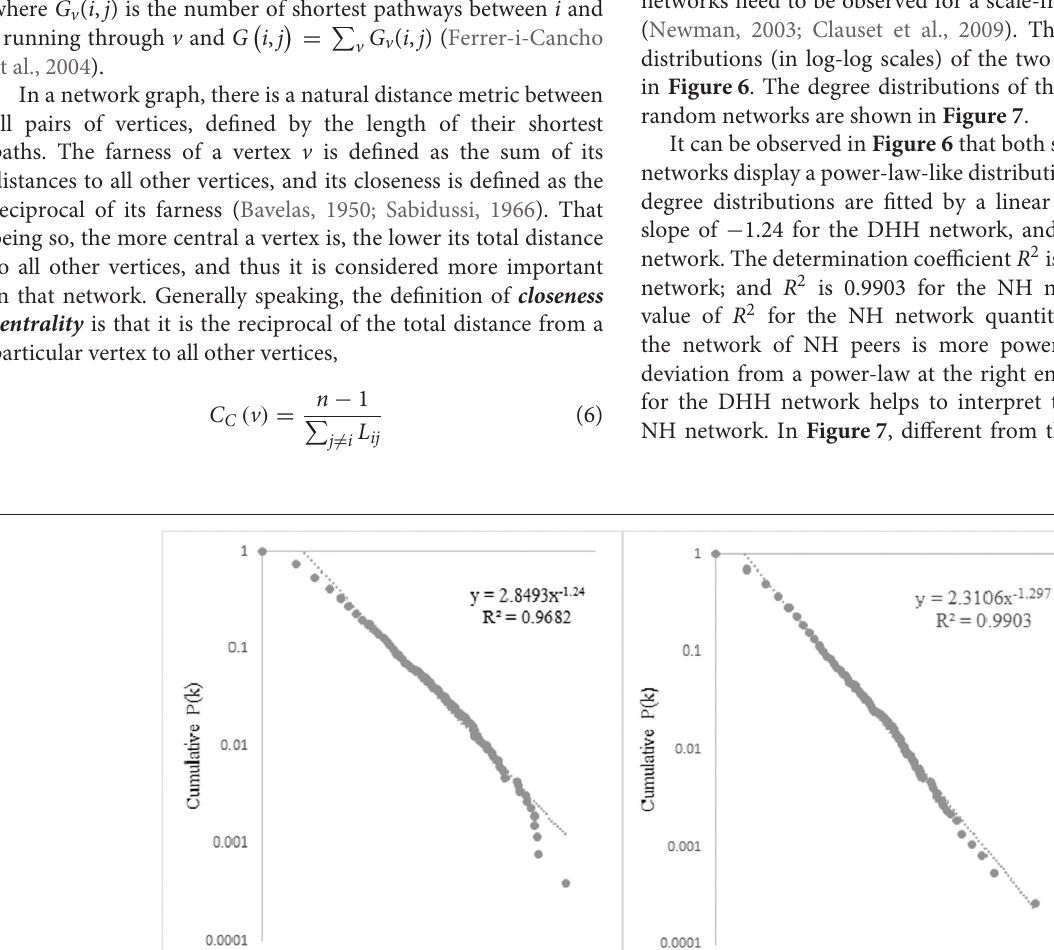
Frontiers in Psychology |